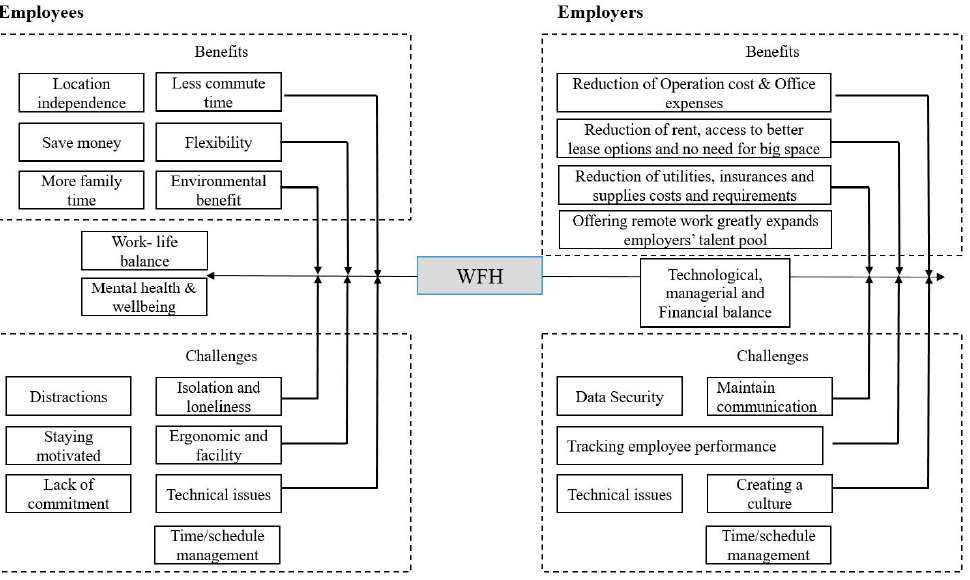
Figure 2. Benefits and challenges of working from home for employers and employees.